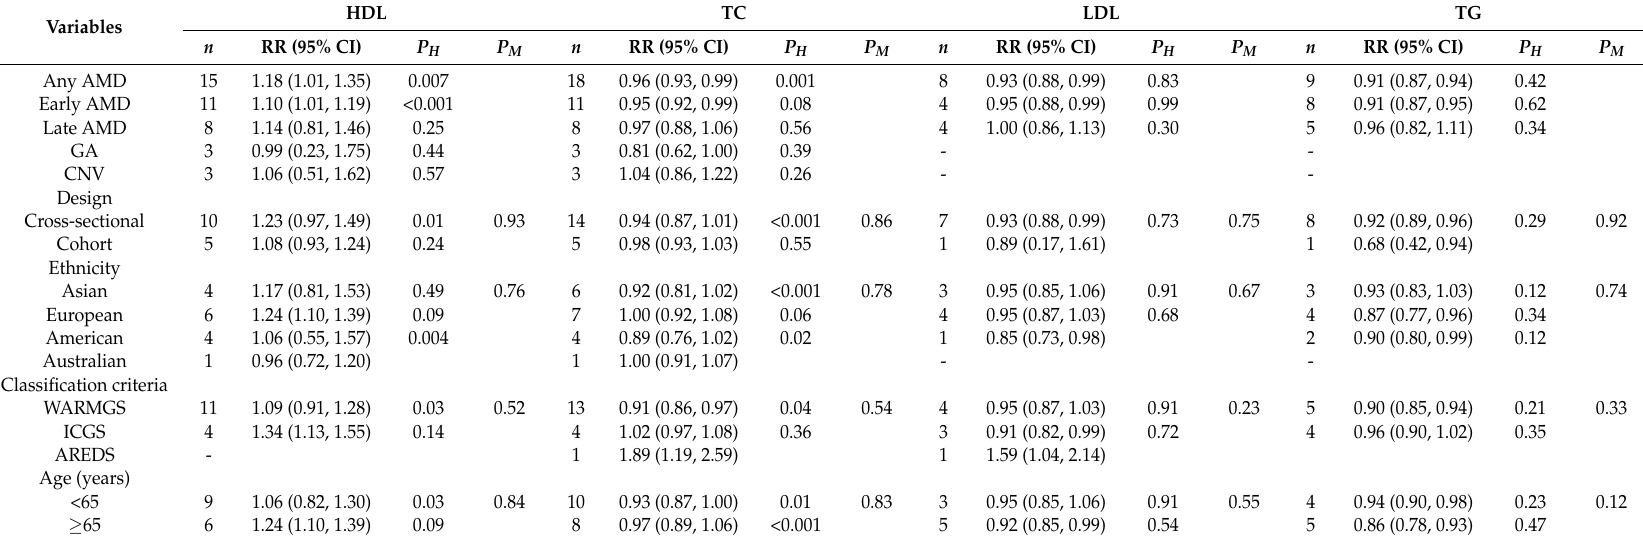
Table 2. Subgroup analysis of the association between blood lipids and age-related macular